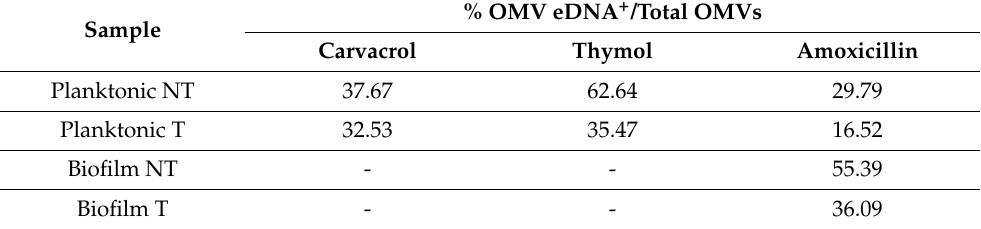
Table 3. Percentages of OMV eDNA + , on the total OMVs, obtained from the planktonic and biofilm phenotypes, treated (T) and untreated (NT) with sub-MIC concentrations of carvacrol, thymol, and amoxicillin. Percentages were not analysed when OMV-generating cell colonies were not detected in treated samples